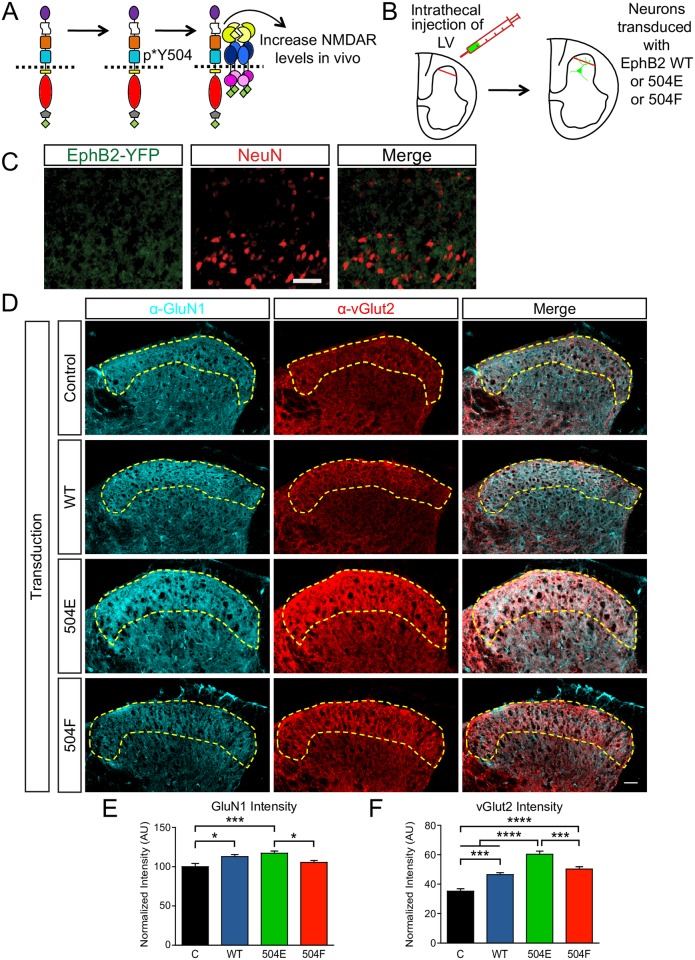
Expression of EphB2 recruits the N-methyl-D-aspartate receptor (NMDAR) to synaptic regions of the dorsal horn.(A) Model for effects of EphB2 extracellular phosphorylation on the EphB—NMDAR interaction. (B) Experimental approach using intrathecal injection of lentivirus (LV) to avoid effects outside of the spinal cord. Examination of injection site revised transduced neurons within the dorsal horn. (C) Neuronal viral transduction was confirmed with NeuN labeling (marker for neuronal nucleus) surrounded by EphB2- enhanced yellow fluorescent protein (EYFP) wild type (WT). The left panel was stained for EphB2-EYFP with α-GFP. The middle panel was stained for NeuN. The right panel shows the merged image. Control enhanced green fluorescent protein (EGFP), EphB2-EYFP Y504E, and EphB2-EYFP Y504F also show the distribution surrounding NeuN. Scale bar = 50 μm. (D) Distribution of GluN1 and vGlut2 in the dorsal horn of the adult mouse spinal cord, expressing control EGFP, EphB2-EYFP WT, or Y504E or Y504F mutants. The left panel shows GluN1 (cyan). The middle panels show vGlut2 (red) to mark superficial layers of dorsal horn. The right panel shows a merged image of GluN1 and vGlut2 staining. The dashed yellow line indicates superficial layers of dorsal horn. Scale bar = 50 μm. (E) Quantification of the effects of expression of EphB2 WT and Y504E and Y504F mutants on GluN1 intensity in superficial layers of the dorsal horn of the adult mouse spinal cord (*p < 0.05, ***p < 0.05, ANOVA followed by Tukey’s range test, 17 sections from 3 mice for control, 18 sections from 3 mice for EphB2 WT, 22 sections from 4 mice for Y504E mutant, and 24 sections from 4 mice for Y504F mutant). (F) Quantification of the effects of expression of EphB2 WT and Y504E and Y504F mutants on vGlut2 intensity in superficial layers of the dorsal horn of the adult mouse spinal cord. (***p < 0.0005, ****p < 0.0001, ANOVA followed by Tukey’s range test, 17 sections from 3 mice for control, 18 sections from 3 mice for EphB2 WT, 22 sections from 4 mice for Y504E mutant, and 24 sections from 4 mice for Y504F mutant). AU, arbitrary unit.